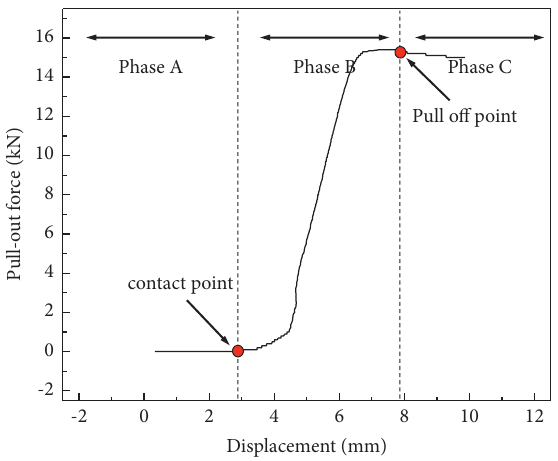
Figure 6: Loading and displacement